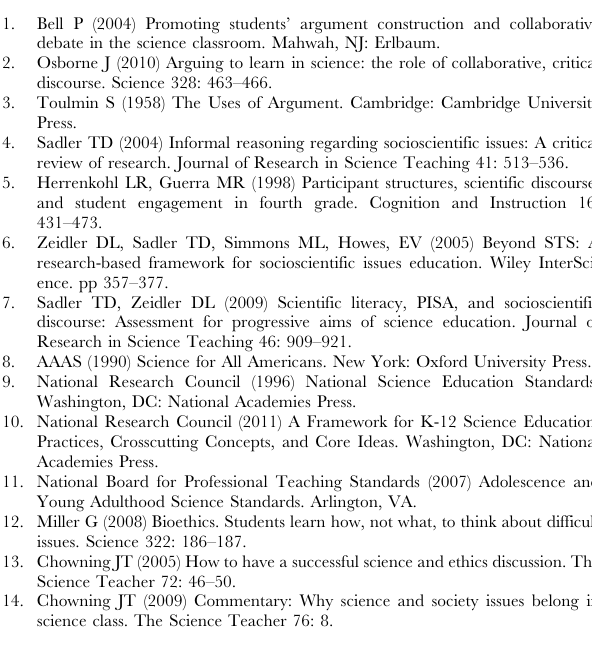
Table S3 Grading Rubric for Pre- and Post-Test: Ashley’s